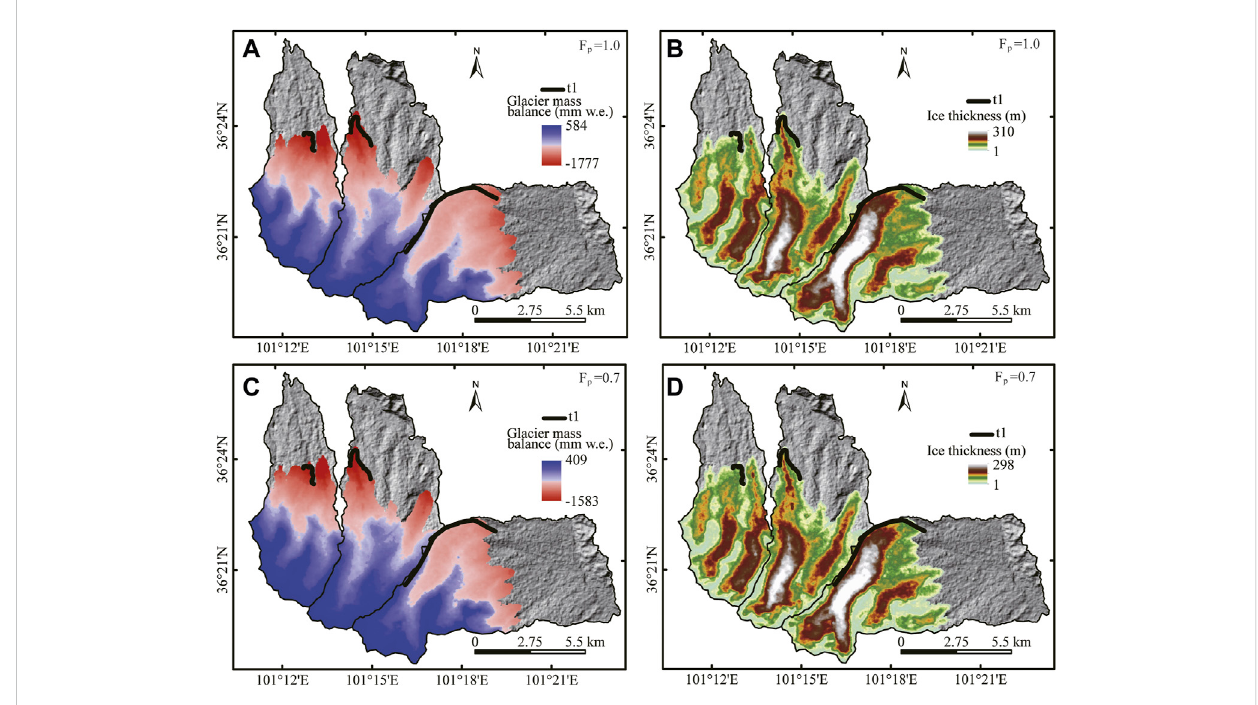
FIGURE 5 Simulated glacier mass balances and extents for the LGM with F p of (A,B) .9 and (C,D) .7.